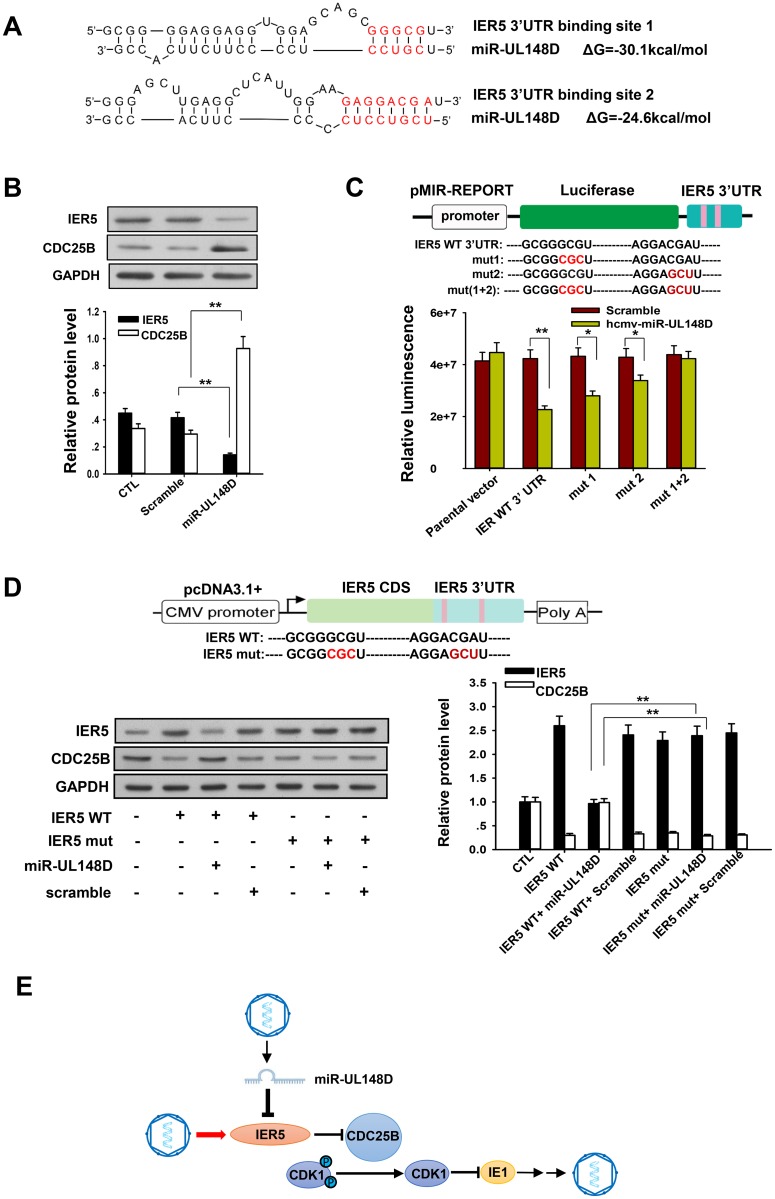
HCMV miR-UL148D directly targets the 3’UTR of IER5 to upregulate CDC25B.(A) Schematic of miR-UL148D-binding sites on IER5, with the two seed-recognizing sites marked in red. The predicted free energy of each hybrid is indicated. (B) Downregulation of IER5 and upregulation of CDC25B protein levels in Kasumi-3 cells induced by miR-UL148D mimics. The protein levels of IER5 and CDC25B in Kasumi-3 cells 48 hours after transfection with miR-UL148D mimics were assayed with western blotting. GAPDH served as an internal control. (C) Upper panel: construction of luciferase reporter that expresses the IER5 3’UTR with or without mutation of miR-UL148D-binding sites. Mutations of the seed-recognizing sites in the IER5 3’UTR are marked in red. Lower panel: firefly luciferase activity in 293T cells that were co-transfected with various luciferase reporter constructs for the IER5 3’UTR and miR-UL148D, normalized to β-gal activity. (D) Upper panel: Construction of an expression vector harboring the ORF and 3’UTR of IER5 with or without mutation of the two miR-UL148D-binding sites. The mutations in the binding sites in the IER5 3’UTR are marked in red. Lower panel: Expression levels of IER5 and CDC25B in Kasumi-3 cells that were co-transfected with wild-type IER5 (IER5 WT) or mutated IER5 (IER5 Mut) and miR-UL148D or a scrambled oligonucleotide. Protein levels were detected by Western blot analysis after a 72-h transfection. The efficiency of transfection was monitored by assaying β-gal activity. (E) Schematic representing the hypothesis for how miR-UL148D facilitates HCMV latency. Values are shown as the mean ± SEM (n = 3). **, P<0.01.